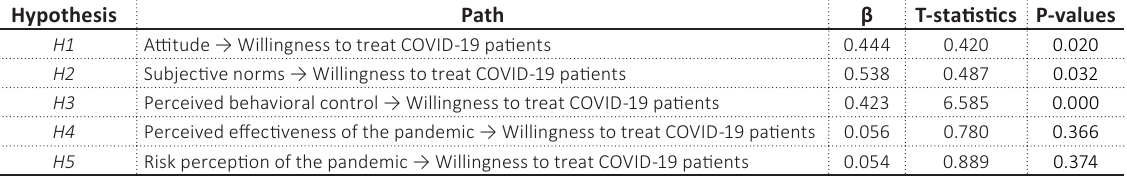
Table 4. Path coefficient Hypothesis